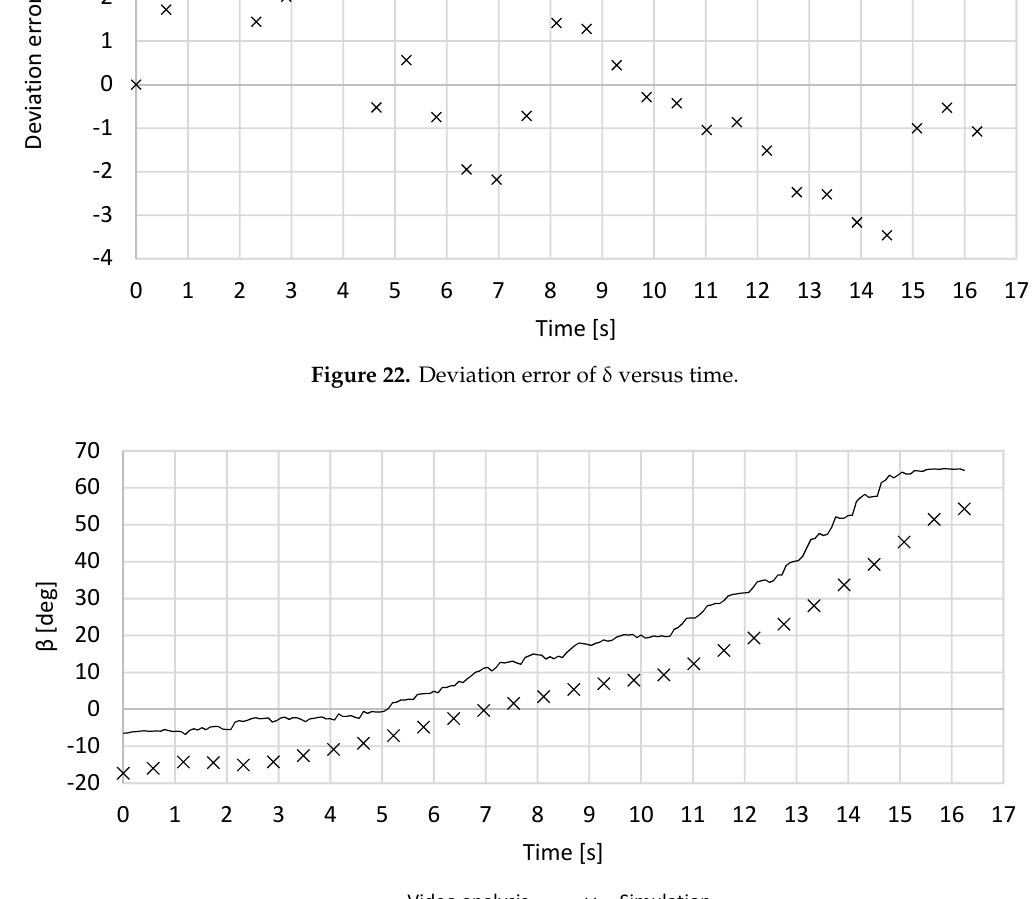
Figure 23. Comparison of β from the experimental test (continuous line) and simulation (x marks) versus time.